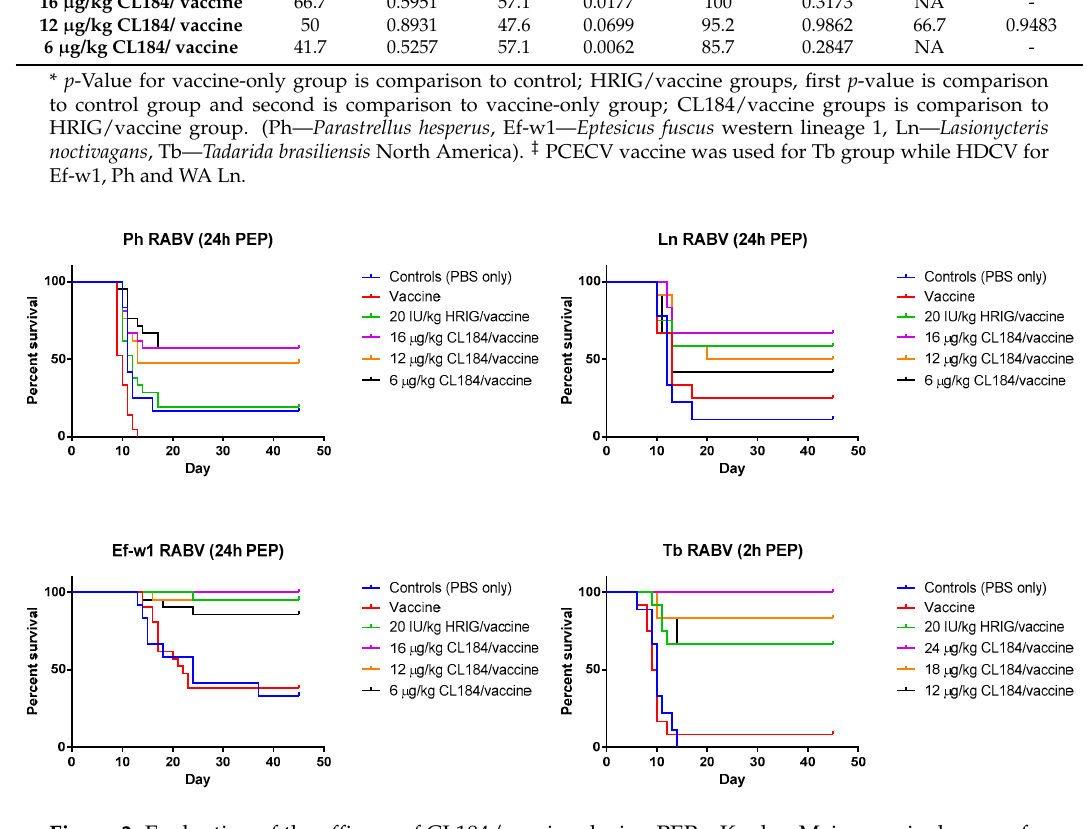
Figure 3. Evaluation of the efficacy of CL184/vaccine during PEP—Kaplan-Meier survival curves for Syrian hamsters after infection with bat rabies viruses. Hamsters ( n = 12 or 21 per group) infected with a RABV isolate 2 or 24 h prior to intervention received PEP as outlined in Materials and Methods.